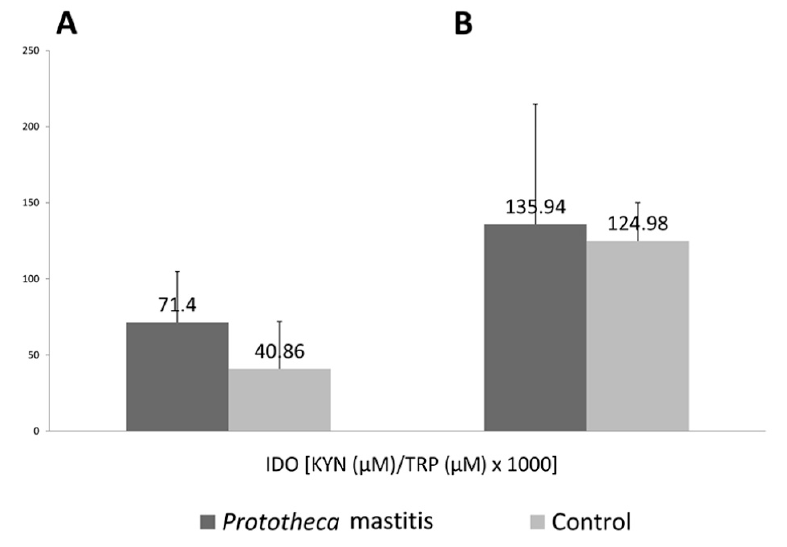
Figure 2. IDO activity in milk ( A ) and serum ( B ) of cows with Prototheca mastitis and control animals. Numbers above the bars are median values, while vertical lines represent standard